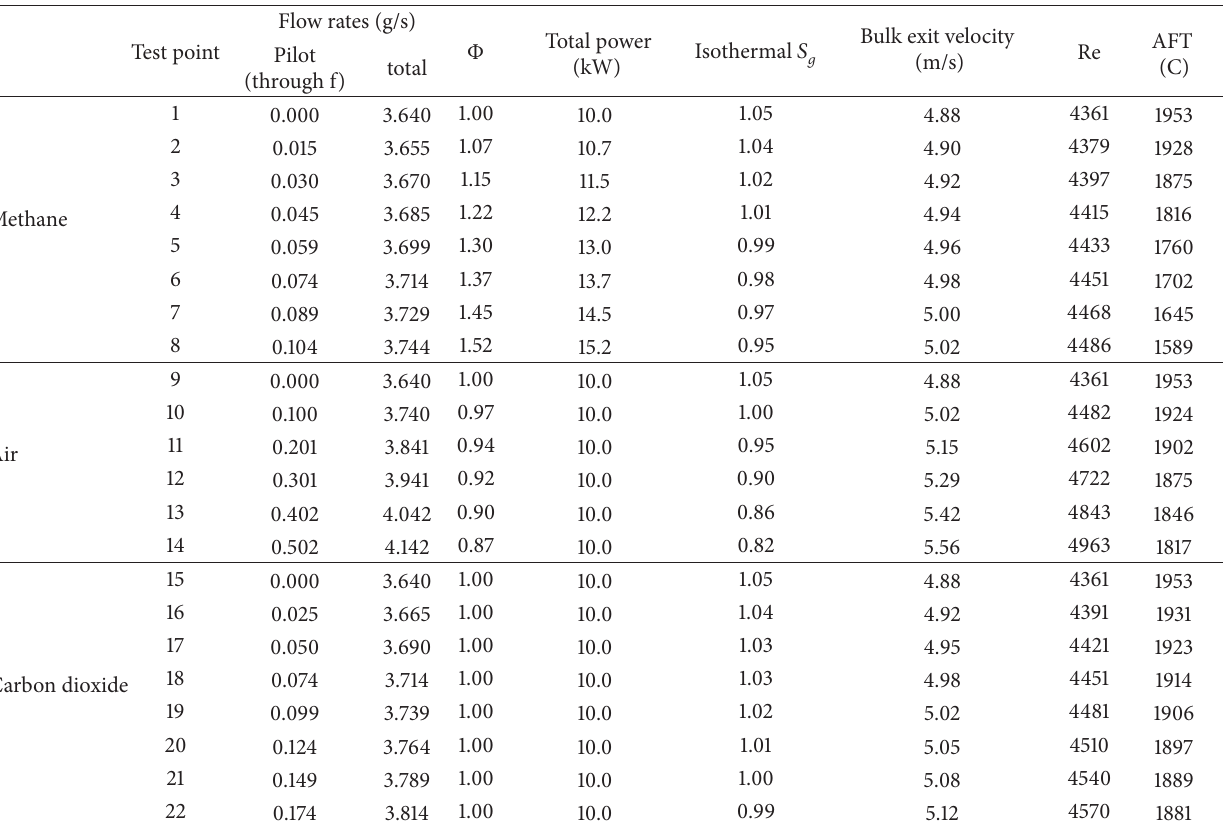
Table 1: Details of AGSB test points